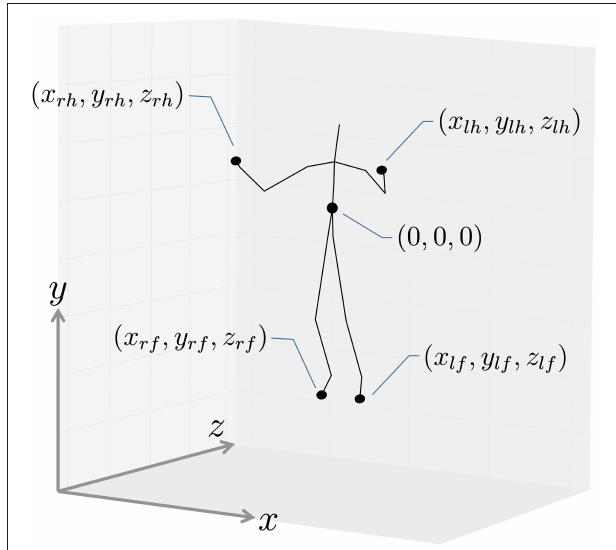
FIGURE 7 | Coordinate system used in the experiments.